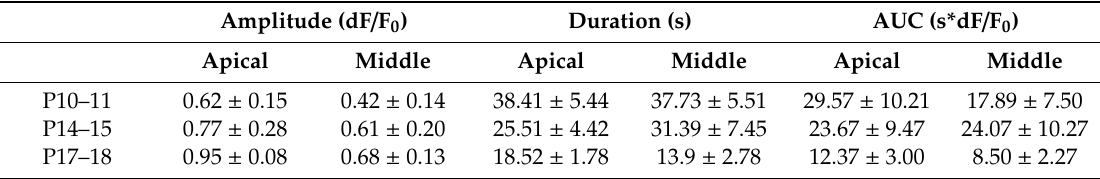
Table 5. Magnitude and kinetic characteristic of UTP (100 µ M) induced Ca 2 + transients in the phalangeal process of Deiters’ cells (mean ± SEM).